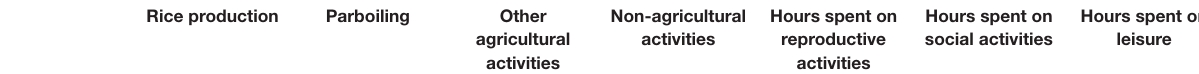
TABLE 4 | Correlation among labor inputs for rice farmers in Burkina Faso, Côte d’Ivoire, Madagascar, and Sierra Leone. Rice